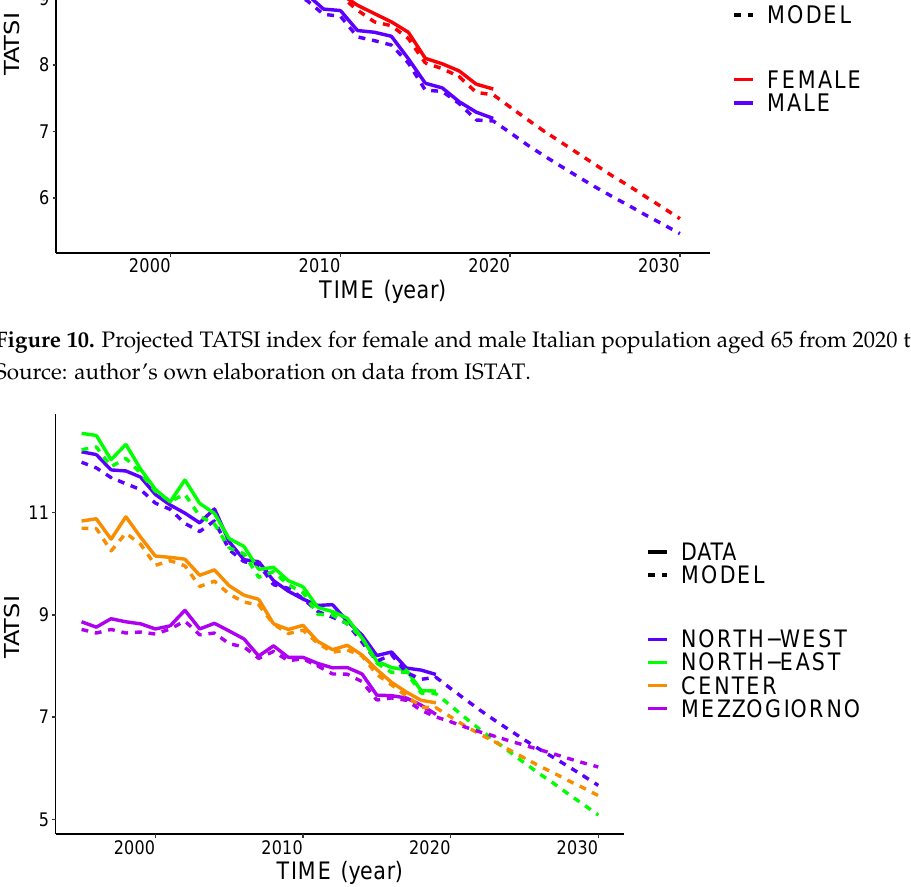
Figure 11. Projected TATSI index for total, male, and female Italian population aged 65 from 2020 to 2030 across macroareas (NUTS-1 level). Source: author’s own elaboration on data from